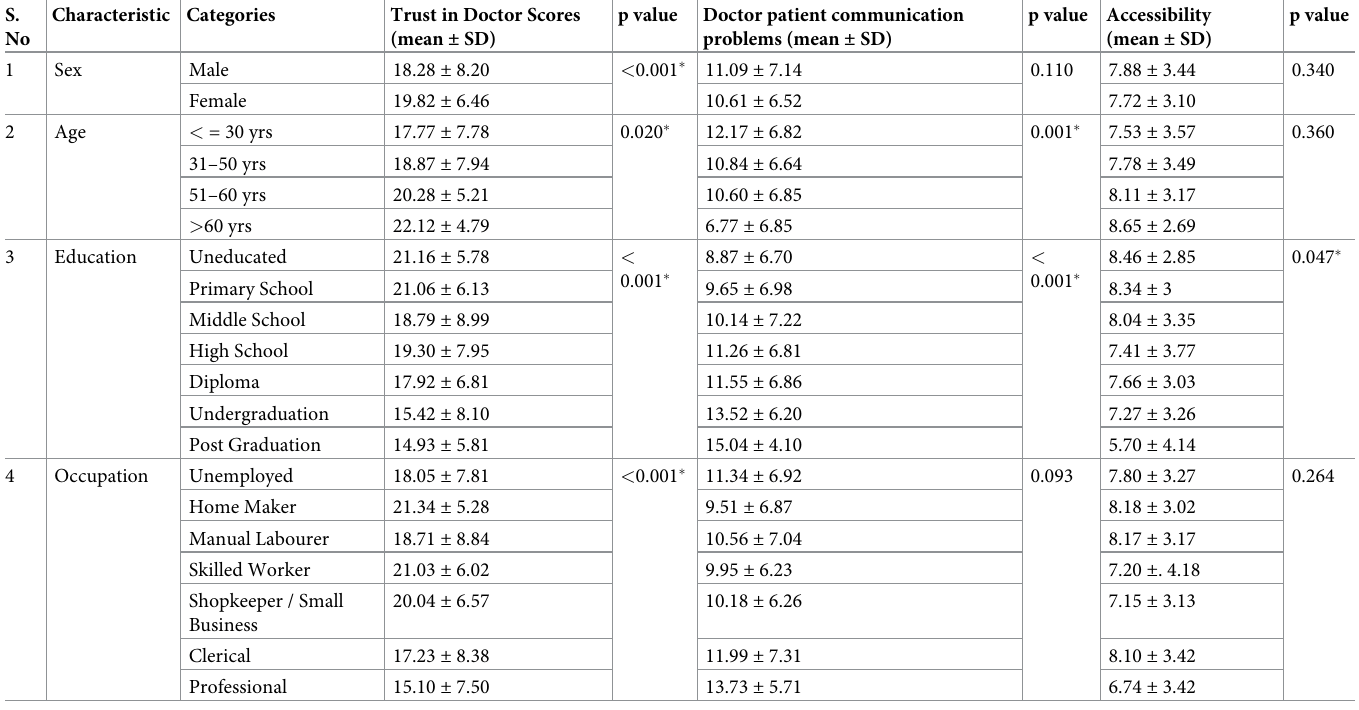
Table 5. Comparison of accessibility, doctor-patient communication and trust in doctors based on characteristics of the participants.